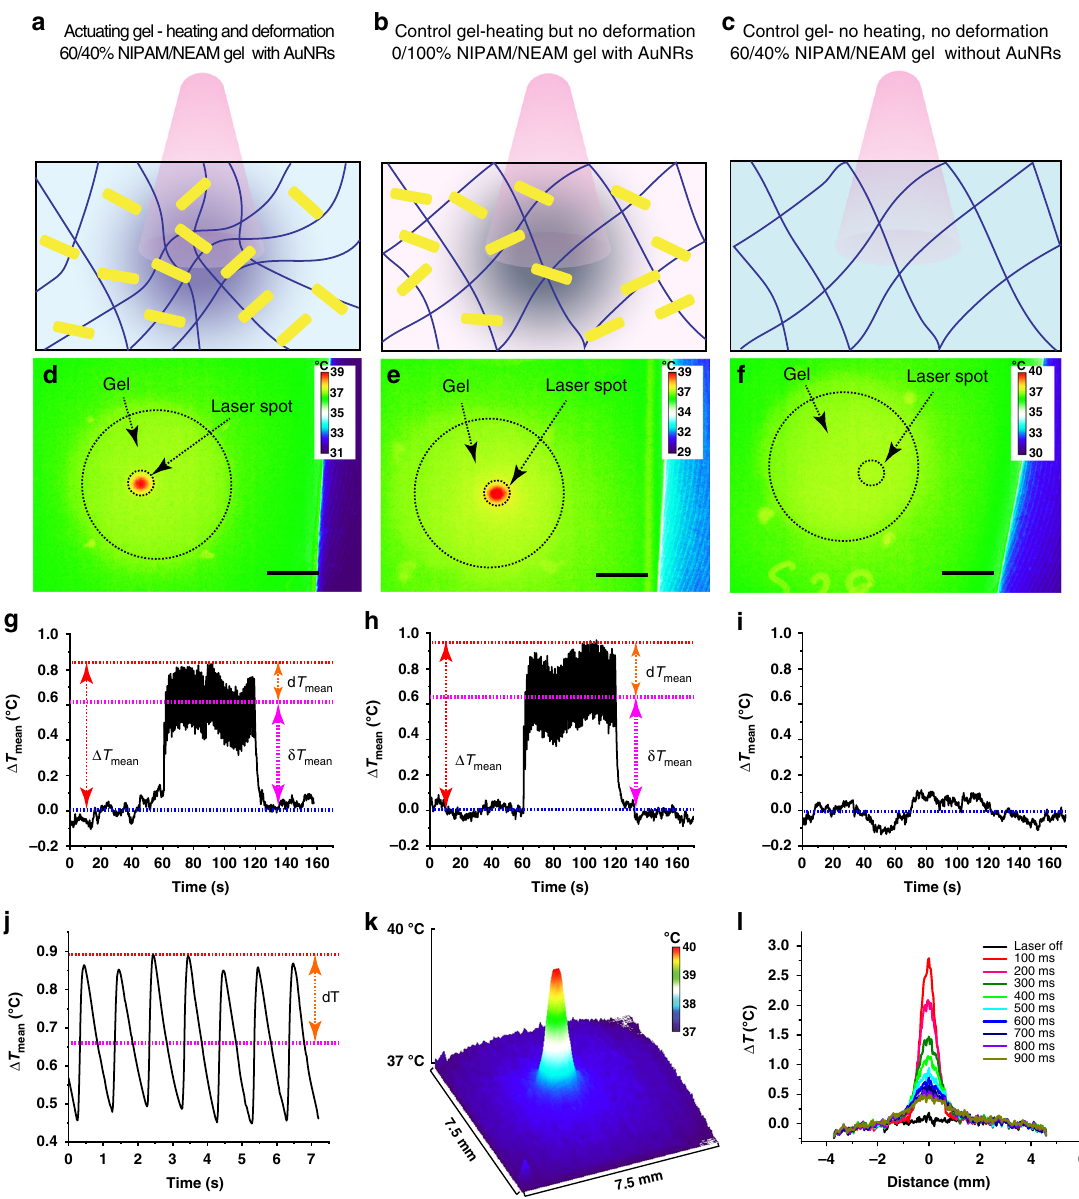
Fig. 2 Temperature modulation during actuation does not exceed hyperthermia temperature. A schematic of a 60/40 NIPAM/NEAM gels with AuNRs, which actuate and show temperature changes when irradiated with NIR light, b 0/100 NIPAM/NEAM gels with AuNRs, which show a temperature gradient but do not actuate when irradiated with NIR laser, c 60/40 NIPAM/NEAM gels without AuNRs, which do not actuate or generate a temperature gradient when irradiated with NIR laser. The temperature gradient is depicted with color shading and the deswelling is shown by changes in the mesh size (not to scale). d – f Representative thermal images obtained during photothermal heating of the gels for a – c , respectively, scale bar = 3 mm. The laser is turned on at ~60 sec (340 mW, 1 Hz, 100 ms laser ON time) and turned off at ~120 sec. g – i Temperature pro fi les for the pulsed laser, calculated from images as depicted in d – f , respectively. j The mean temperature of the irradiated portion of the gel oscillates with the laser frequency. k A surface plot of the gel temperature, showing the spatial control of actuation. l The spatial temperature pro fi le changes with the laser pulse, which is turned on at t = 0 ms. (340 mW, 1 Hz, 100 ms ON